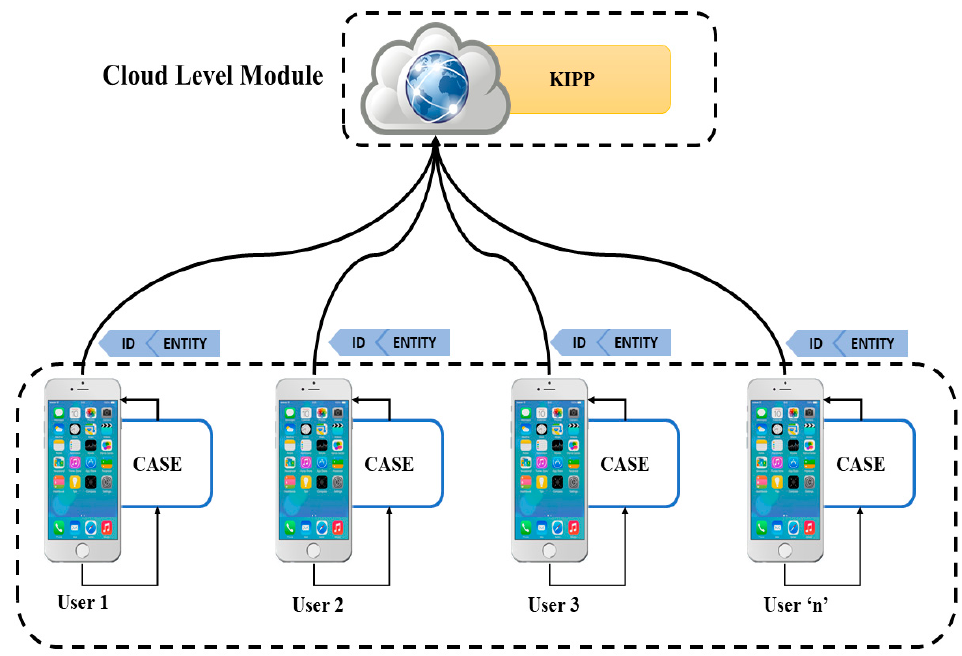
Figure 1. Architecture of MaLang. Table 2. Toxic content and different classes.